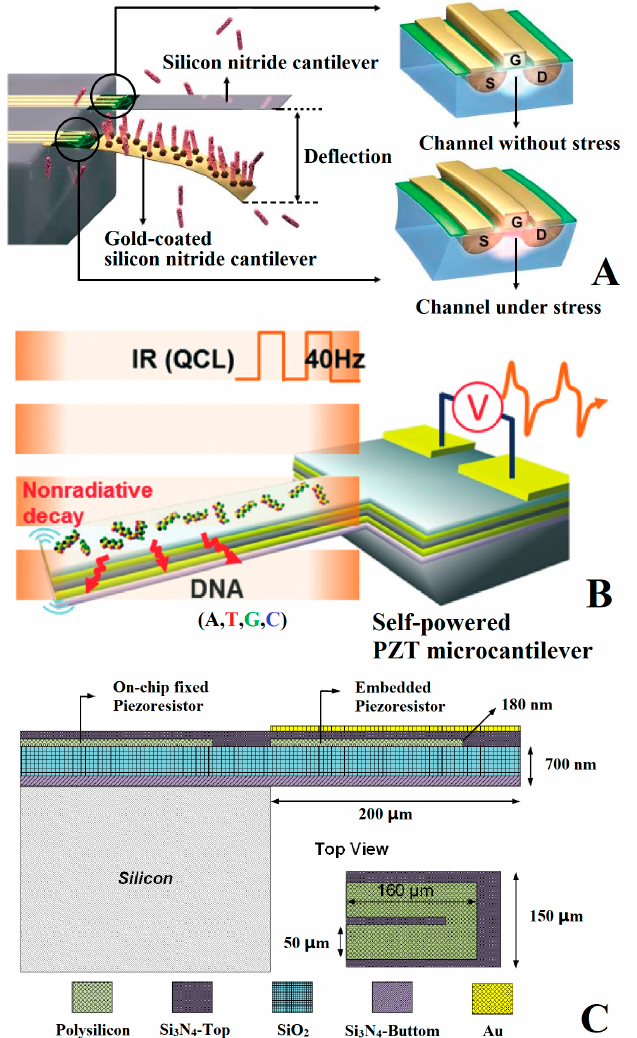
Figure 6. Improved scheme of electric signal extraction method. ( A ) Schematic of the interaction between probe and target molecules on an embedded-MOSFET cantilever system [76]; ( B ) schematic diagram of infrared pyroelectric detection system based on a PZT microcantilever [77]; ( C ) piezoresistive microcantilever sensor chip design with temperature compensation resistance [78].